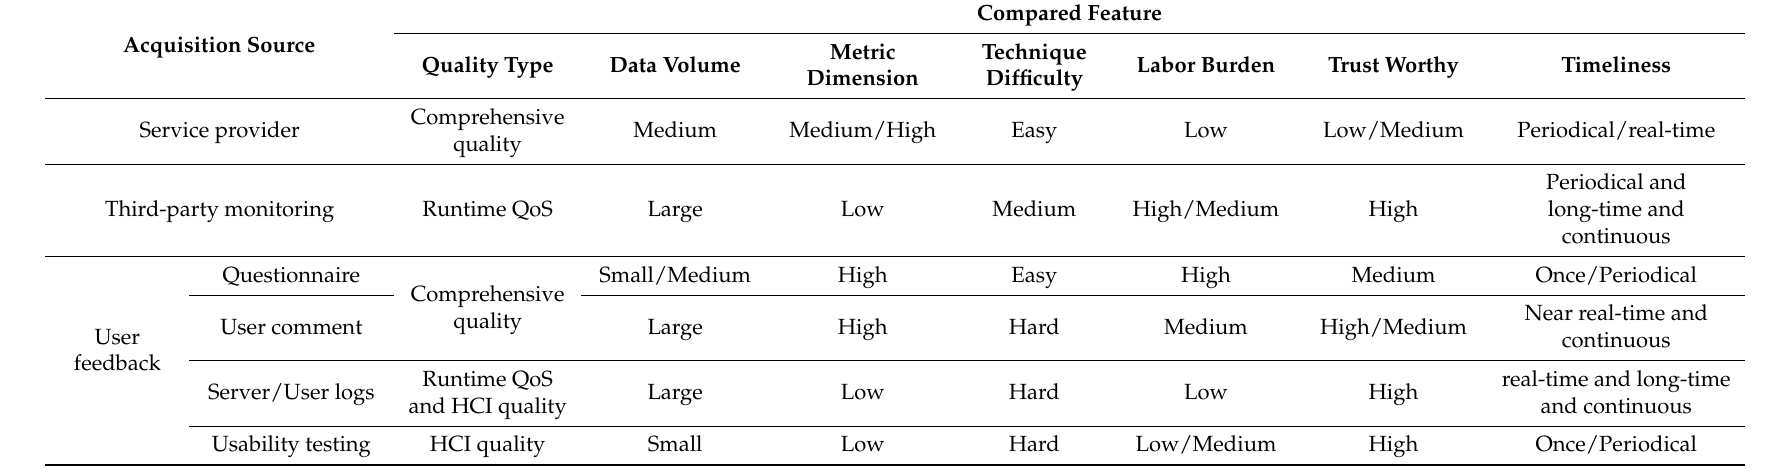
Table 2. A comparison of multiple QoGIS acquisition